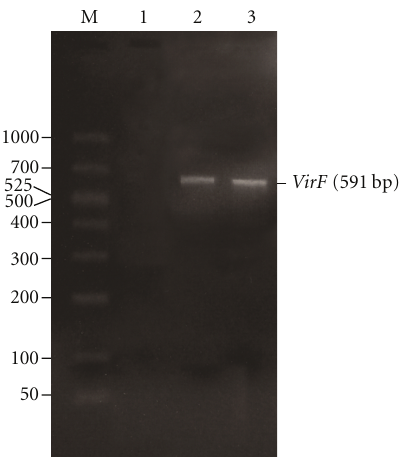
Figure 3: Detection of pYV in cells recovered from red pin- point colony and subcultured in brain heart infusion broth at 28 ◦ C by PCR assay targeting virF gene of pYV. The primer pairs (5 (cid:3) -TCATGGCAGAACAGCAGTCAG-3 (cid:3) and 5 (cid:3) -ACT- CATCTTACCATTAAGAAG-3 (cid:3) ) for detection of the virF gene (430- to 1020-nucleotide region) amplified a 591 base-pair (bp) product from the virulence plasmid. Lane M, 50–1,000 bp ladder marker; lane 1 showing the absence of 591-bp product in Y . pestis ; lanes 2 and 3 showing the presence of 591-bp product in Y . enterocolitica and Y . pseudotuberculosis,